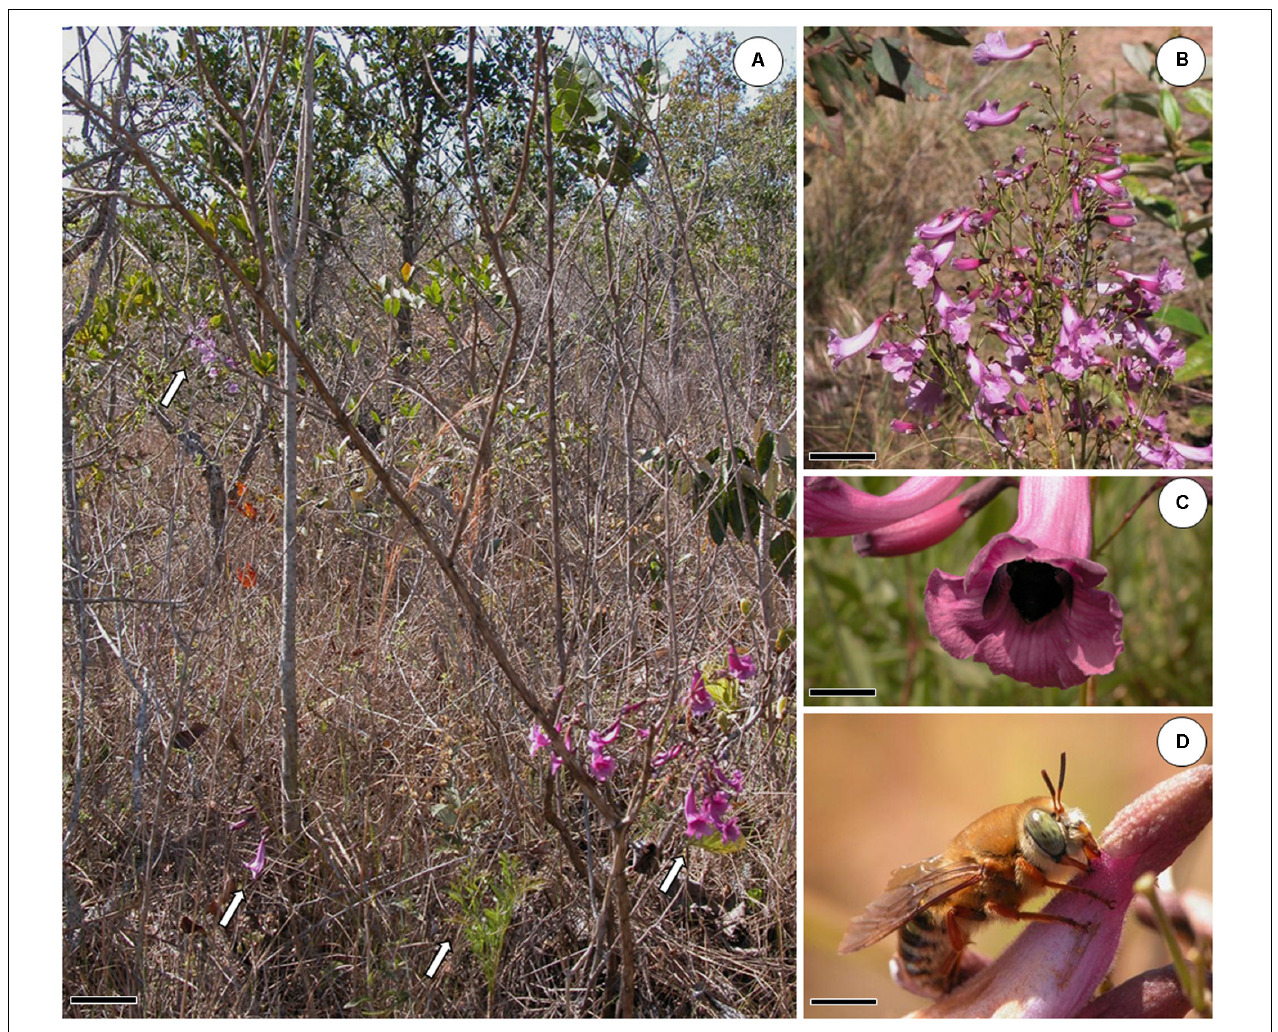
FIGURE 1 | Jacaranda oxyphylla (Bignoniaceae) and its floral visitors. (A) Study site showing “Cerrado” vegetation and four individuals of J . oxyphylla (arrows). Scale bar: 13 cm; (B) detail of an inflorescence of J . oxyphylla . Scale bar: 5 cm; (C) Eulaema nigrita , one of the pollinators of J . oxyphylla , visiting a flower. Scale bar: 1.5 cm; (D) Oxaea flavescens , the main nectar robber of J . oxyphylla flowers, visiting a flower. Scale bar: 0.5